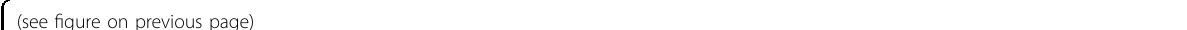
Fig. 5 Role of keratinocyte Plg-R KT in burn wound healing. A Quanti fi cation of the remaining wound area at different time points after wounding of male kPlg-R KT − / − mice and Plg-R KT fl ox / fl ox mice ( n ≥ 7). The mixed-effects model (REML), showed a signi fi cant effect for time ( p < 0.0001, f = 211.9), and a trend for genotype ( p = 0.103, f = 3.158) but no signi fi cant genotype × time interaction ( p = 0.745), f = 0.658). Post hoc testing by two-tailed t test * p = 049. B Scab loss data are shown for cohorts of Plg-R KT fl ox / fl ox and kPlg-R KT − / − mice) ( n = 7). p = 0.669, Χ 2 = 0.182, d f = 1 by the log-rank (Mantel – Cox) test. C Quanti fi cation of epidermal thickness at day 20 after wounding of kPlg-R KT − / − and Plg-R KT fl ox / fl ox mice. D Quanti fi cation of epidermal thickness at day 20 after wounding of mPlg-R KT − / − and Plg-R KT fl ox / fl ox mice. Means ± S.E.M. determined by two-tailed t test is shown